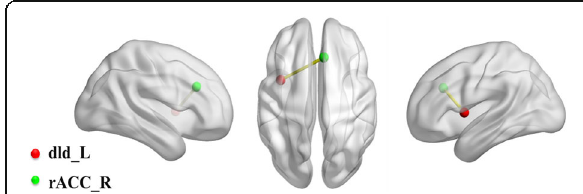
Fig. 2 ROI-ROI analysis of FCs between the 12 insular subdivisions and 64 selected pain-related brain regions. The red ball represented the dId_L, the green ball represented the rACC_R, and the yellow rod represented the statistically increased FC in males. L, left; R, right; dId, dorsal dysgranular insula; rACC, rostral anterior cingulate cortex; ROI, region of interest; FCs, functional connectivities